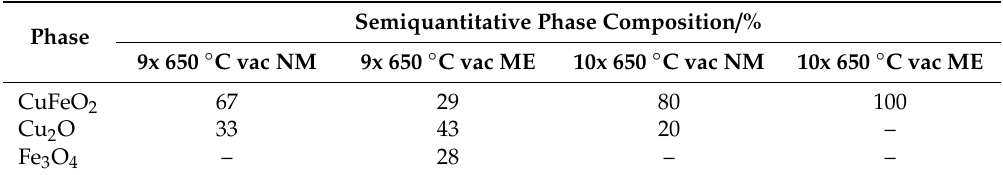
Table 2. Semiquantitative XRD